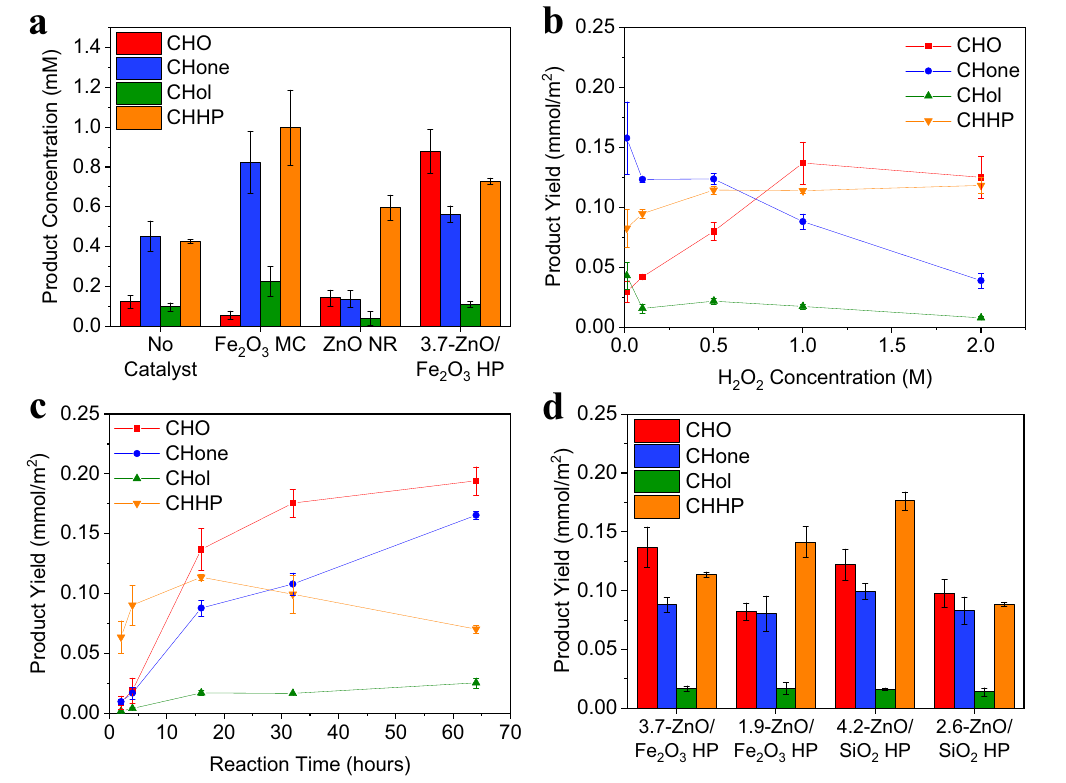
Fig. 3 | Product yield as a function of catalyst, H 2 O 2 concentration, reaction time, and material. Product distributions from the photo-oxidation of CH in a 1:1 (by vol) CH/aqueous H 2 O 2 emulsion with 1 mg/mL catalyst under broad spectrum light a with added 1 M H 2 O 2 for 16h, b as a function of added H 2 O 2 concentration with3.7-ZnO/Fe 2 O 3 HPfor16h, c asafunctionof reactiontimewith3.7-ZnO/Fe 2 O 3